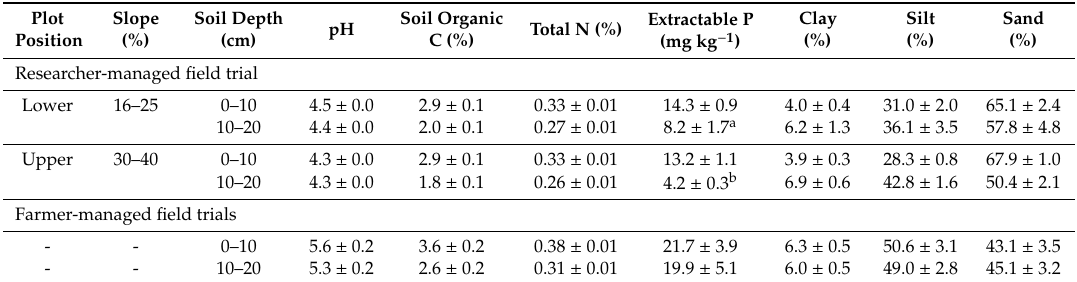
Table 3. Soil characteristics (mean ± standard error) of the field trials.